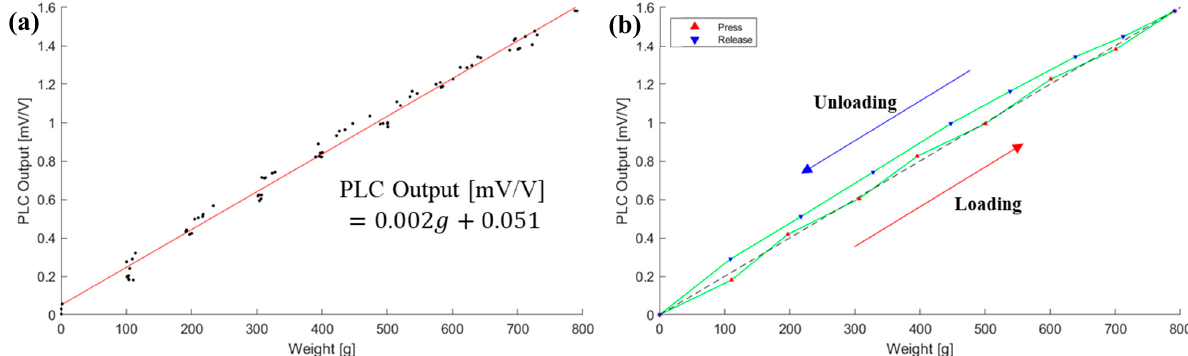
Figure 11. Loading/unloading test of the PLC to the rated load, 0.8 kg: ( a ) 5 time measurements; and ( b ) hysteresis characteristic. Figure 10. Loading/unloading test of the PLC to the maximum analytical load, 2 kg: ( a ) hysteresis characteristic; and ( b ) 5 time measurements.